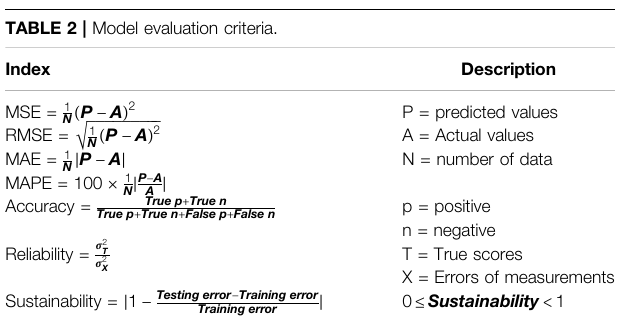
TABLE 2 | Model evaluation